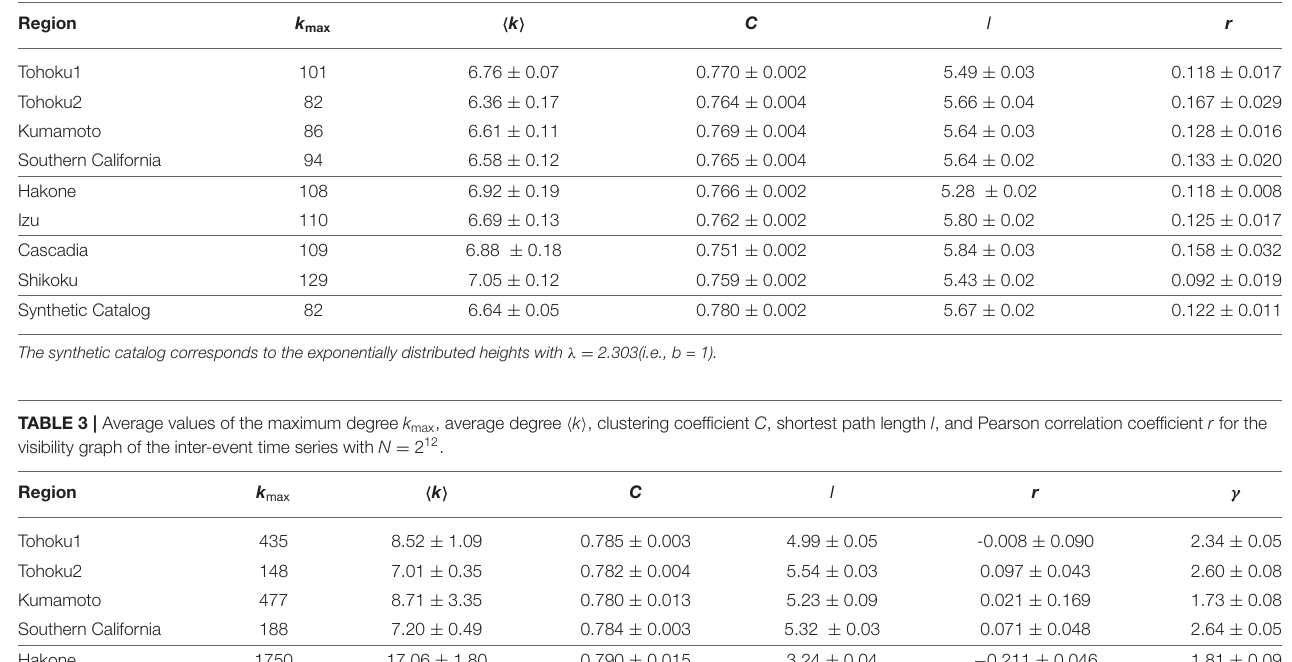
TABLE 2 | Average values of the maximum degree k max , average degree visibility graph of the magnitude time series with N